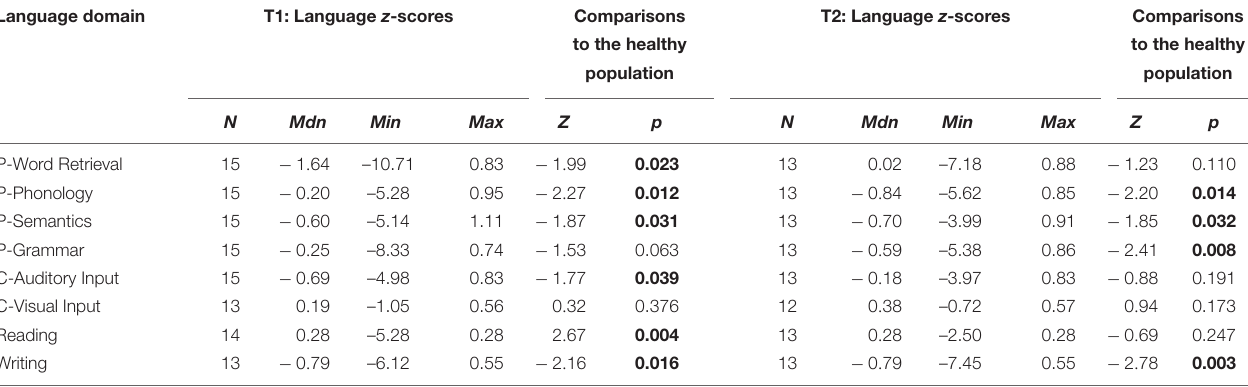
TABLE 4 | Language domain z -scores of glioma patients at T1 and T2, including comparisons to normative data from a healthy population. Language domain